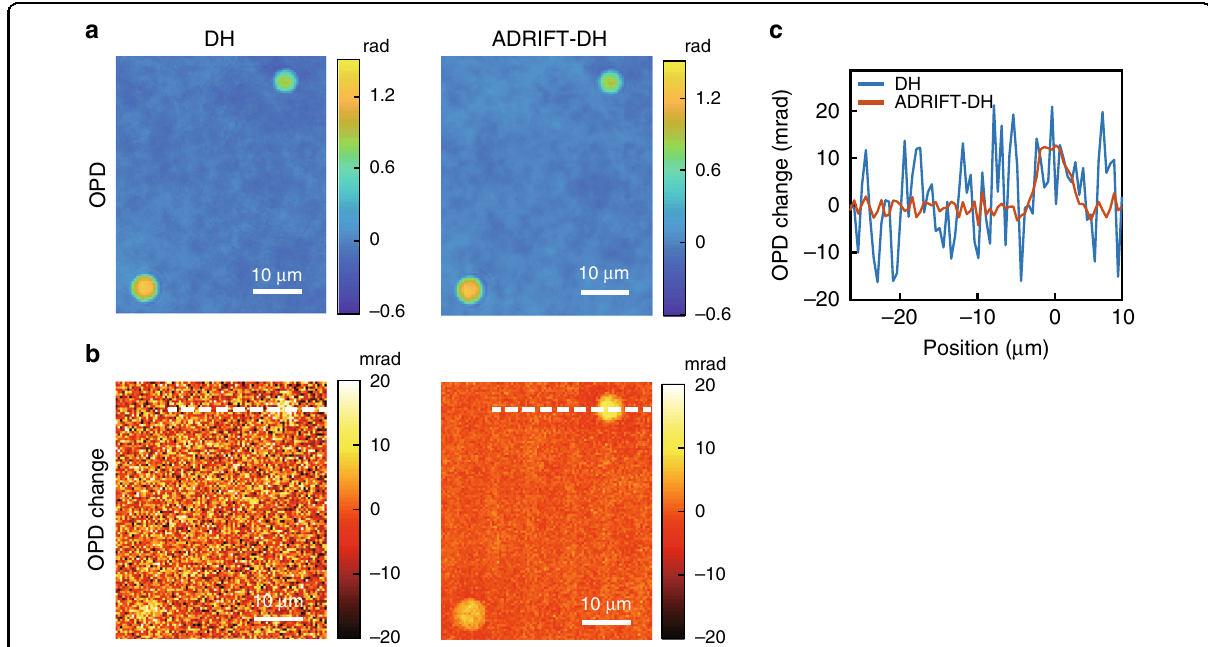
Fig. 4 Dynamic-range-expanded MIR photothermal QPI of silica microbeads. a OPD images measured by DH (left) and ADRIFT-DH (right) in the MIR OFF state. b Images of the photothermal OPD changes due to absorption of the MIR pump light measured by DH (left) and ADRIFT-DH (right). c Cross-sectional pro fi les along the white dotted lines in ( b ). The blue and orange plots represent the results obtained by DH and ADRIFT-DH,